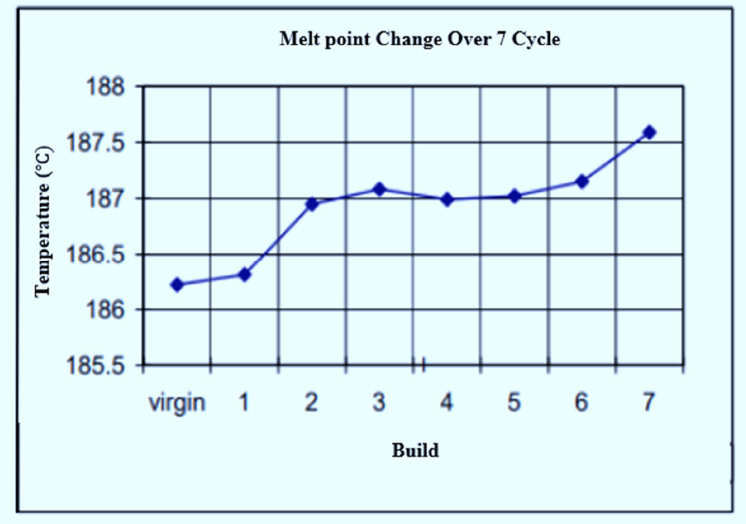
Table 6. Calculated sintering window of Laser PP CP 75 after four re ‐ use cycles. Powder Batch